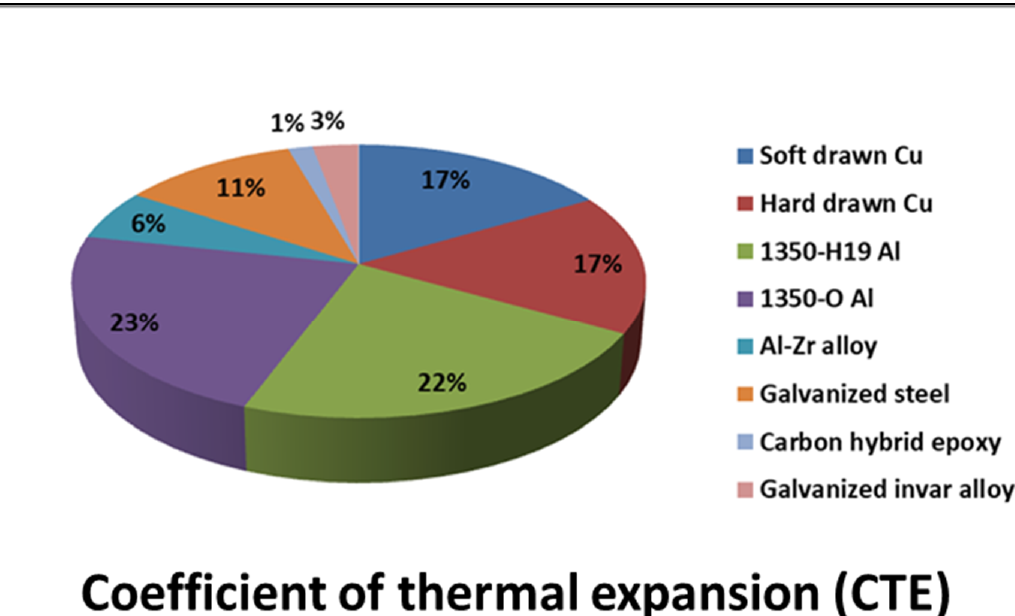
Figure 5. Coefficient of thermal expansion of conductor materials [39].